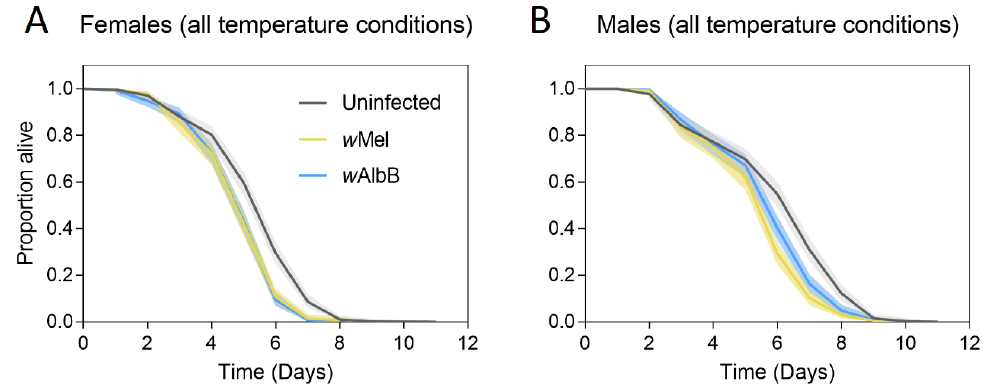
Figure 3. Adult starvation tolerance of female ( A ) and male ( B ) Ae. aegypti with different Wolbachia infection types in the second generation. Mosquitoes were either uninfected (gray lines) or infected with the w Mel Wolbachia strain (yellow lines) or the w AlbB Wolbachia strain (blue lines). Data for all rearing temperature regimes were pooled in these comparisons. Solid lines represent the proportion of adults alive each day, while shaded areas are 95% confidence intervals.